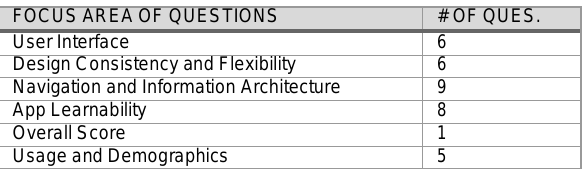
Table 1. Survey focus areas and number of questions.